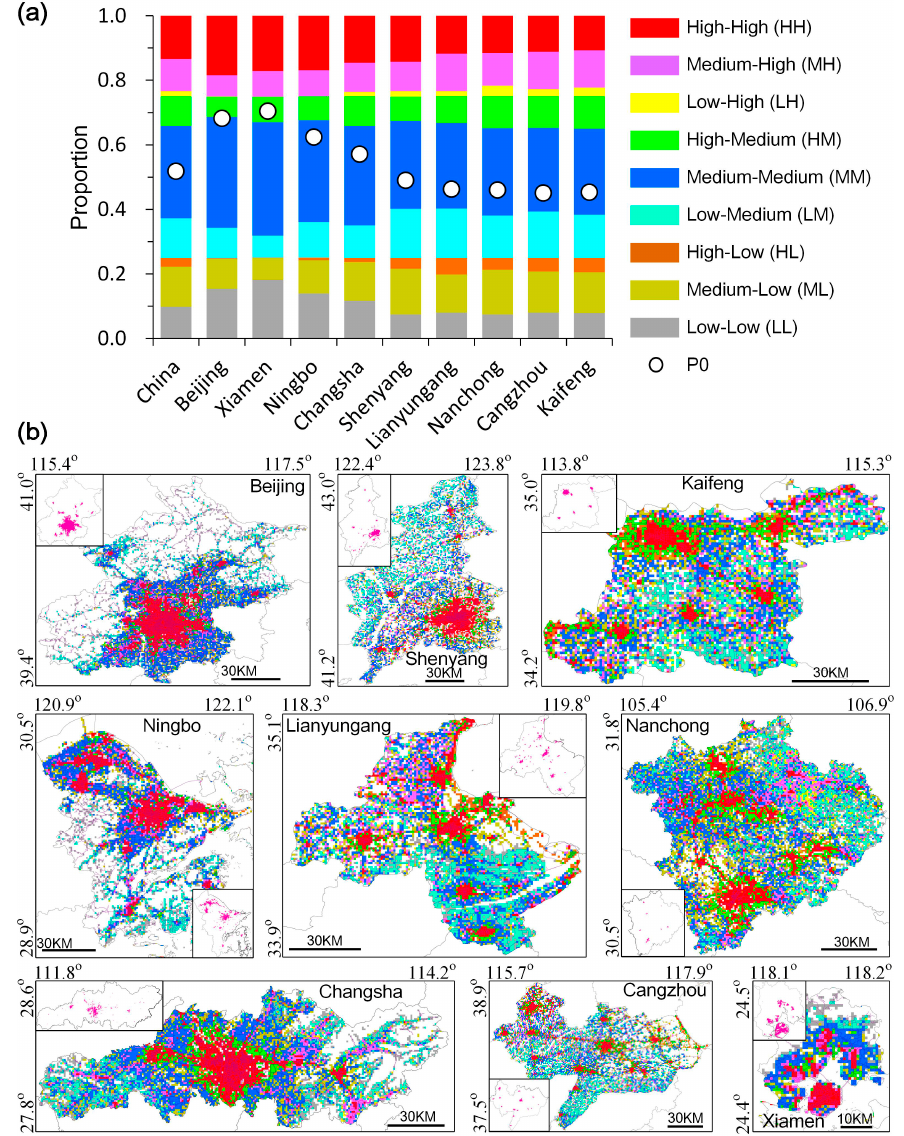
Figure 8. ( a ) Proportions of nine different types of pixels (as defined in Figure 6) for China and nine city-level regions; ( b ) Spatial distributions of the different types of pixels across nine city-level regions. Insets show the spatial distribution of urbanized areas. The setup of false-color ramp is the same as in ( a ).